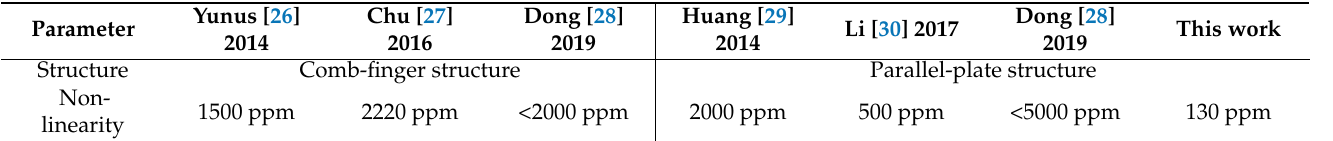
Table 3. Performance comparison between recently reported closed-loop capacitive accelerometers and that in this